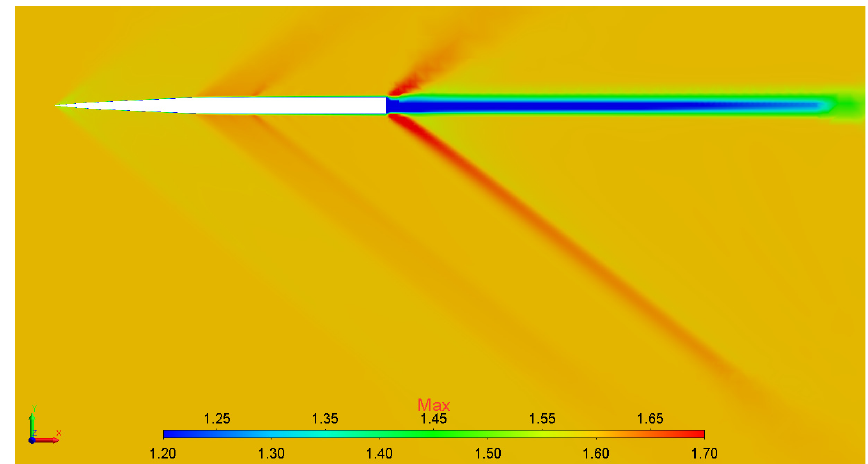
Figure 12. Mach number field, steady-state solution.